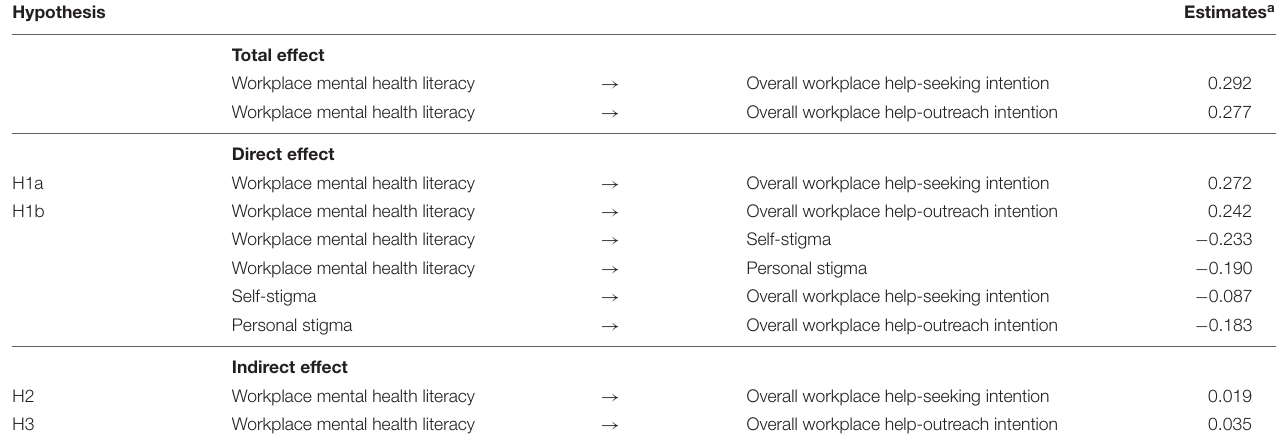
TABLE 4 | Results of the mediation analysis.